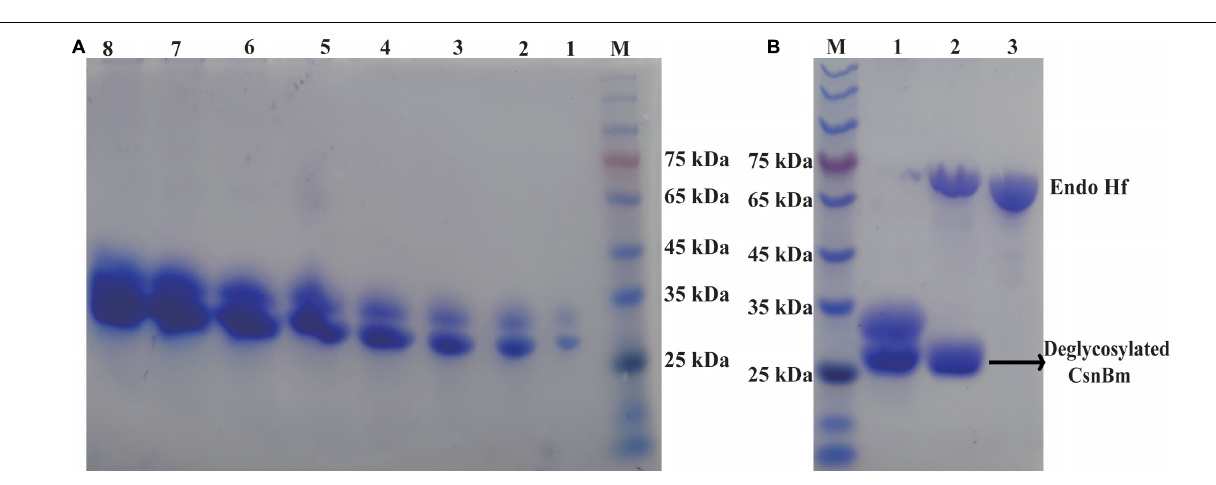
Frontiers in Microbiology |